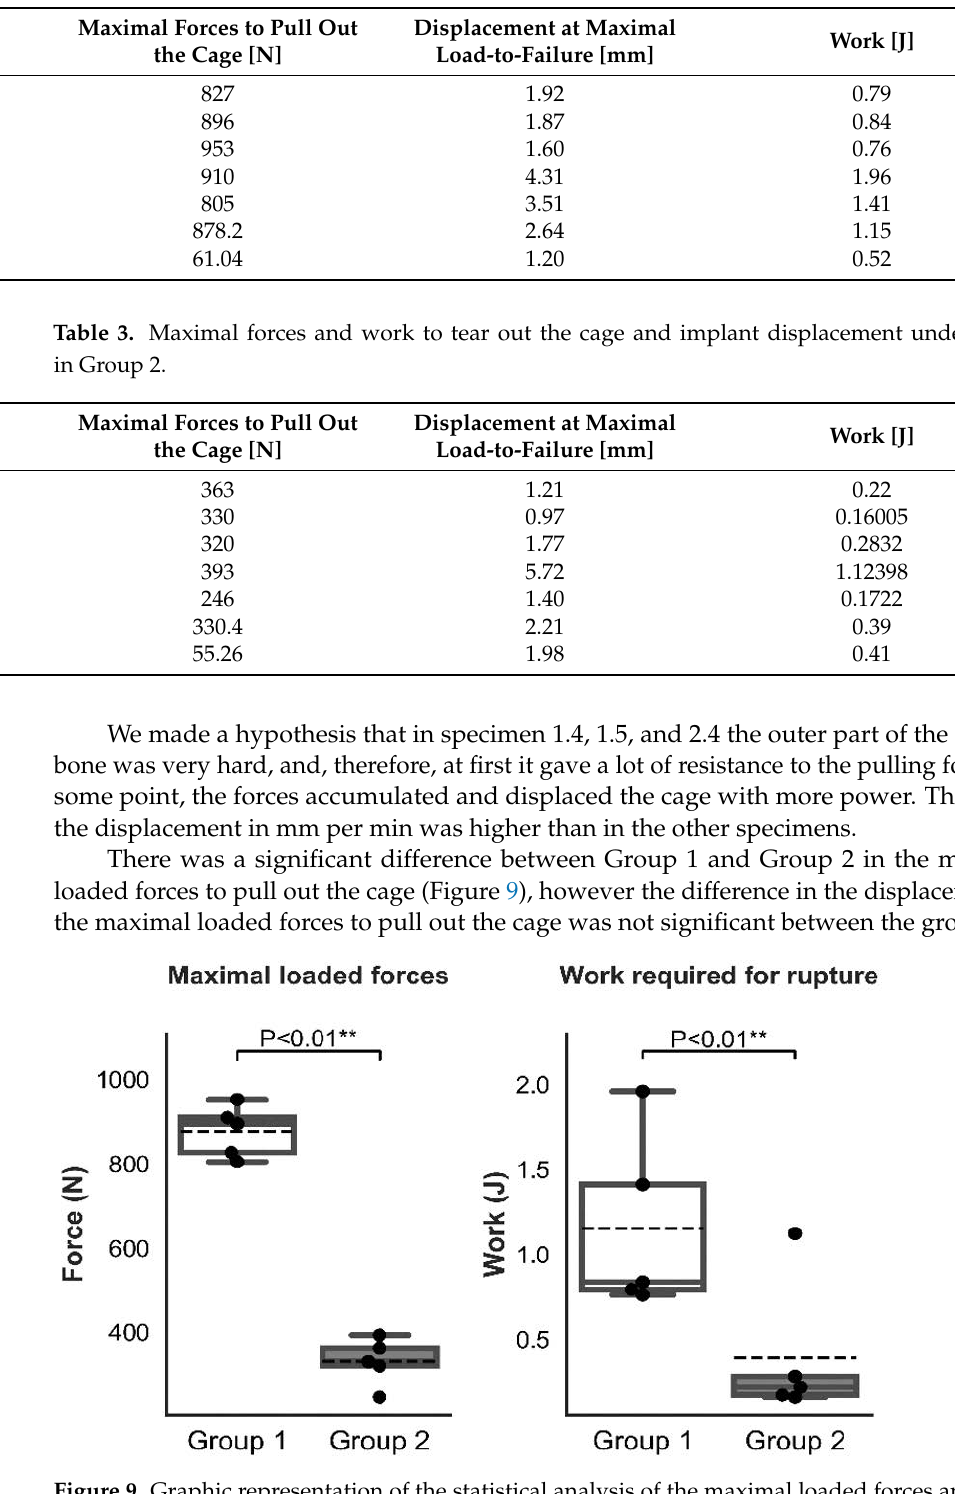
Table 2. Maximal forces and work to tear out the cage and implant displacement under stress in Group 1.